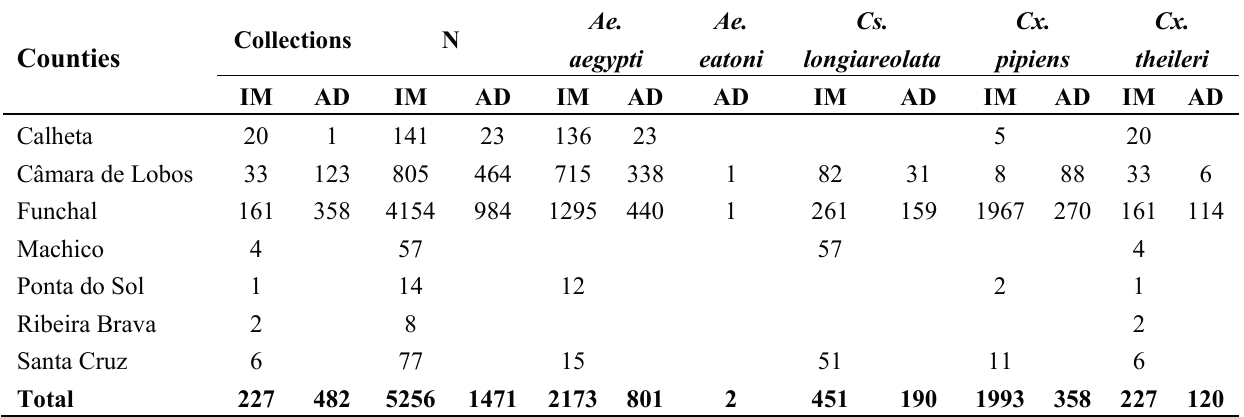
Table 4. Mosquito species identified in the frame of REVIVE in Madeira Island.